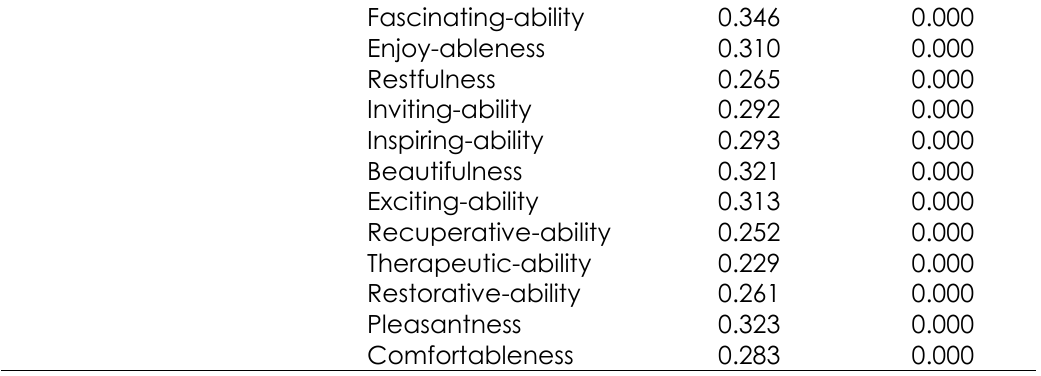
Table 8. Ordinal regressions of perception of quality of open spaces (dependent/outcome) and factors determining the satisfaction of the users (independent/predictors) in Federal Universities in South-west Nigeria University